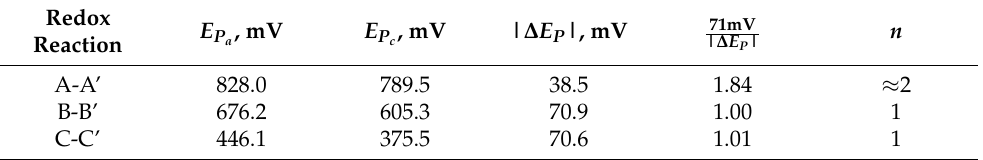
Table 2. Calculation of electron transfer number ( n ) for each redox